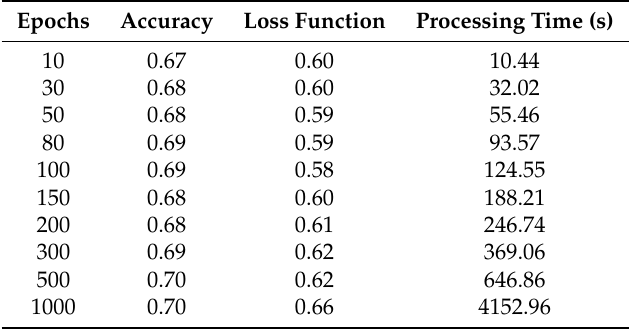
Table 1. Comparison of the accuracy and loss function values obtained using different number of epochs.